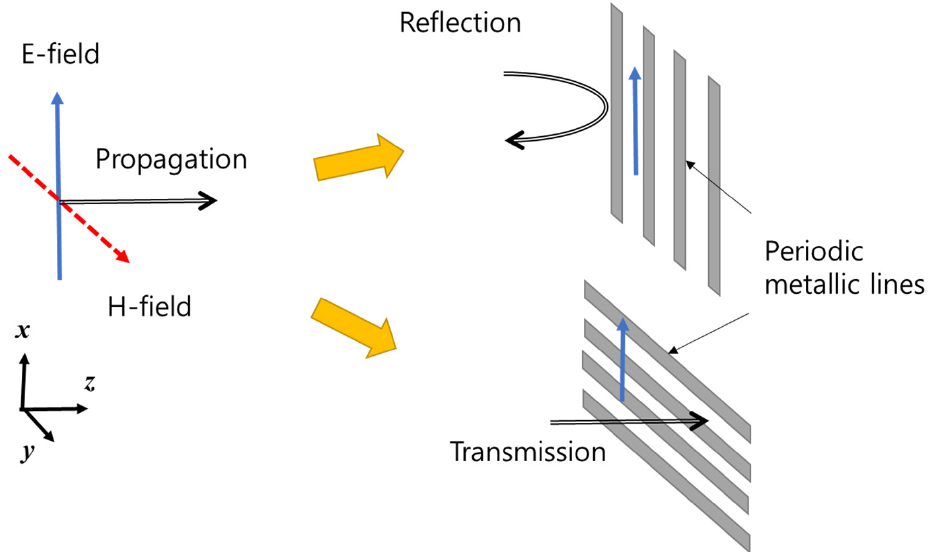
Figure 3. Boundary conditions of electromagnetic waves.